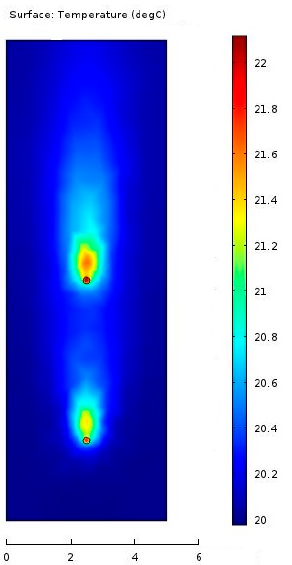
Figure 4. Heat transfer interference between two boreholes. The direction of seepage water flow is upwards increasing the temperature of the second (top) borehole at steady state (modified from [137]).